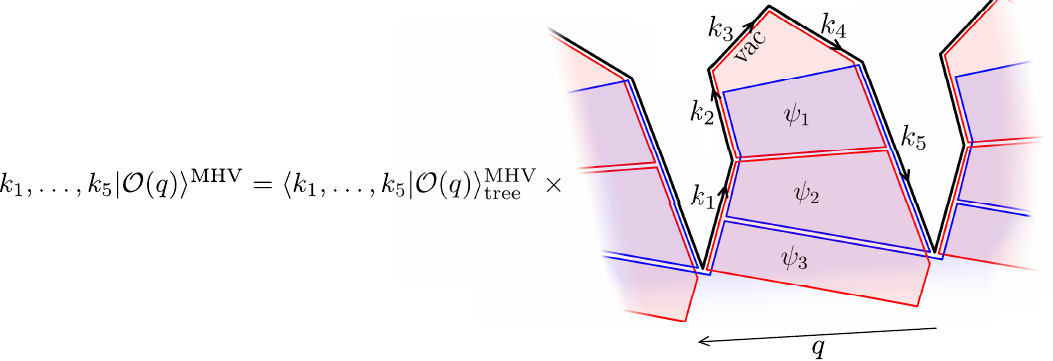
Figure 1 . In the planar limit, an MHV form factor is equal to the expectation value of a wrapped polygonal Wilson loop, multiplied by the tree-level form factor. In the OPE approach, such an n -sided wrapped polygon is decomposed into a sequence of pentagons and a two-sided wrapped polygon. Every two consecutive pentagons overlap on a null square and every two consecutive null squares form a pentagon. The last pentagon likewise overlaps with the two-sided wrapped polygon on a null square. Every square that arises from these overlaps shares two of its opposite cusps with the n -sided wrapped polygon. For the last (bottom) square, these two cusps coincide with one of the cusps of the two-sided wrapped polygon and its periodic image. Here, this decomposition is illustrated for n = 5